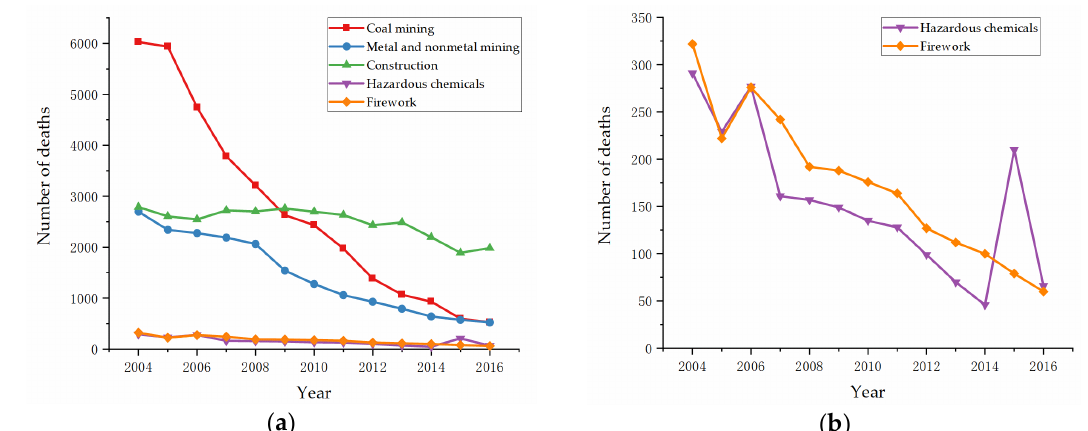
Figure 1. Numbers of deaths caused by accidents in high-danger industries in China: ( a ) Coal mining, metal and nonmetal mining, construction, hazardous chemicals, and firework; ( b ) hazardous chemicals and firework.